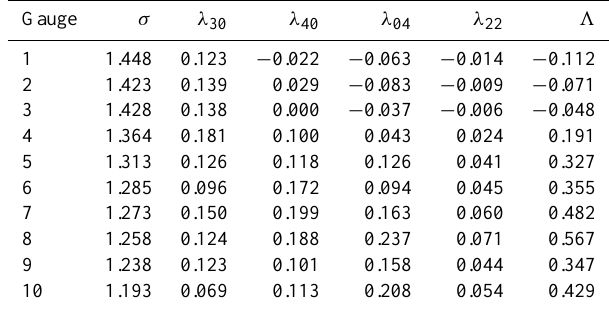
Table 4. Overall statistical averages from 15min segments for 8229: H s =4.6/2.3m, T p =7/20s.